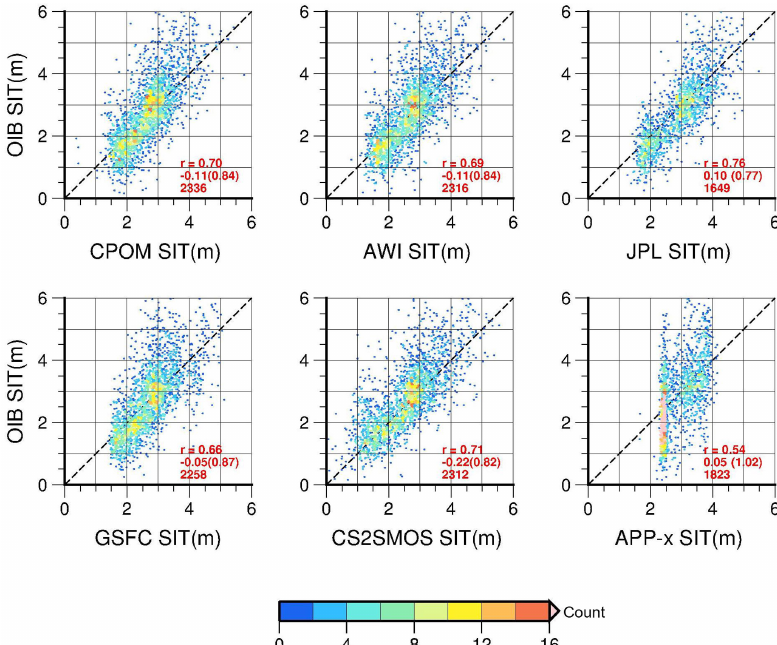
Figure 9. Comparison of satellite-derived ice thickness with Operation IceBridge thickness estimates at the end of the winter growth season (March–April). Comparisons were conducted by gridding satellite and aircraft data onto a common 0.4 ◦ latitude by 4 ◦ longitude grid and using grid cells in which both data sets contained thickness estimates. Colour indicates measurement density (number of data points within each 0.01m cell). Statistics for correlation ( r ), mean difference (SD) and number of data points are calculated for the period 2011–2017, with the exception of the JPL product, wherein statistics are calculated for the period 2011–2015, and the APP-x product, which excluded spring